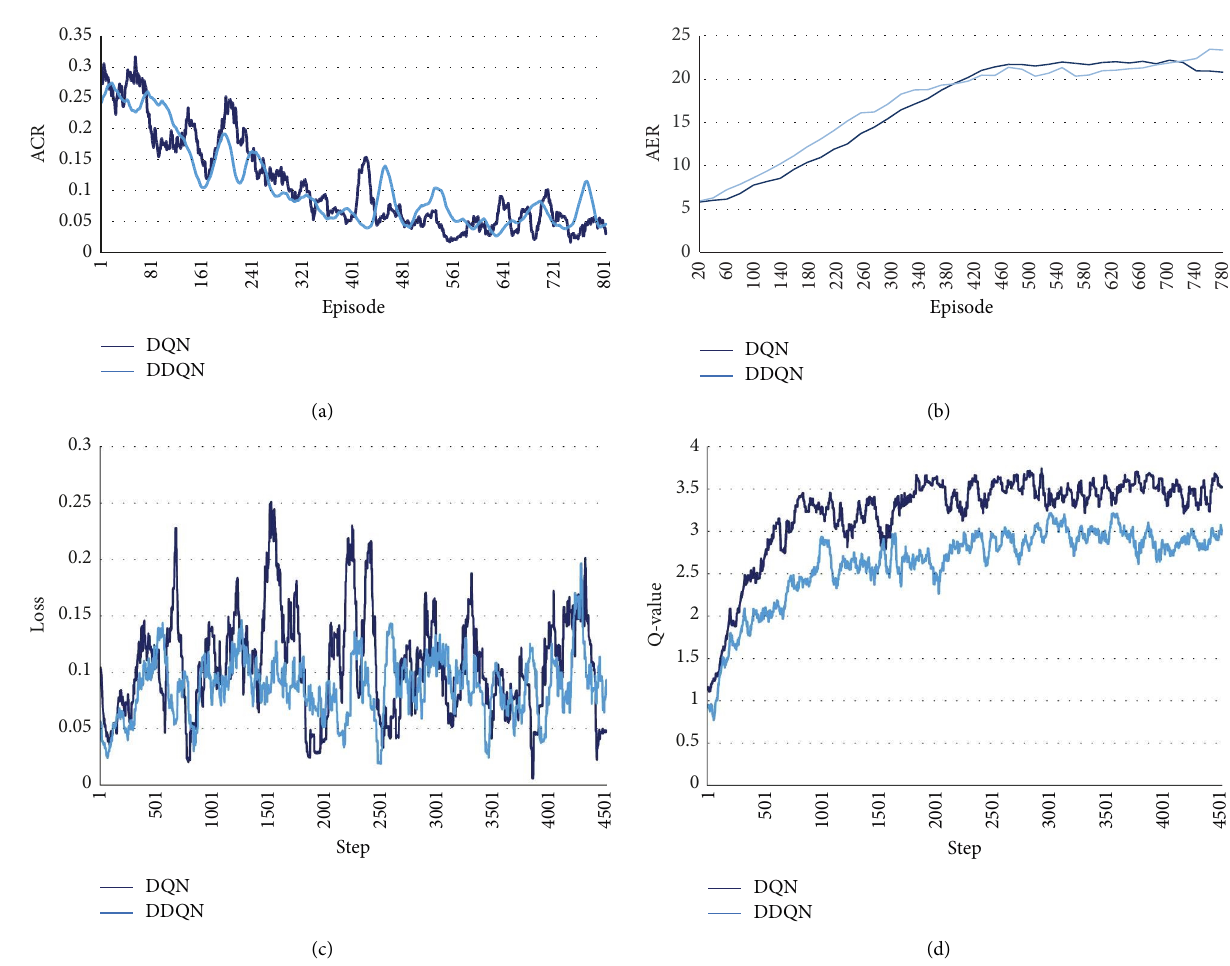
Figure 8: Performance comparison between DQN and DDQN. (a) ACR. (b) AER.(c) Loss. (d) Q value.